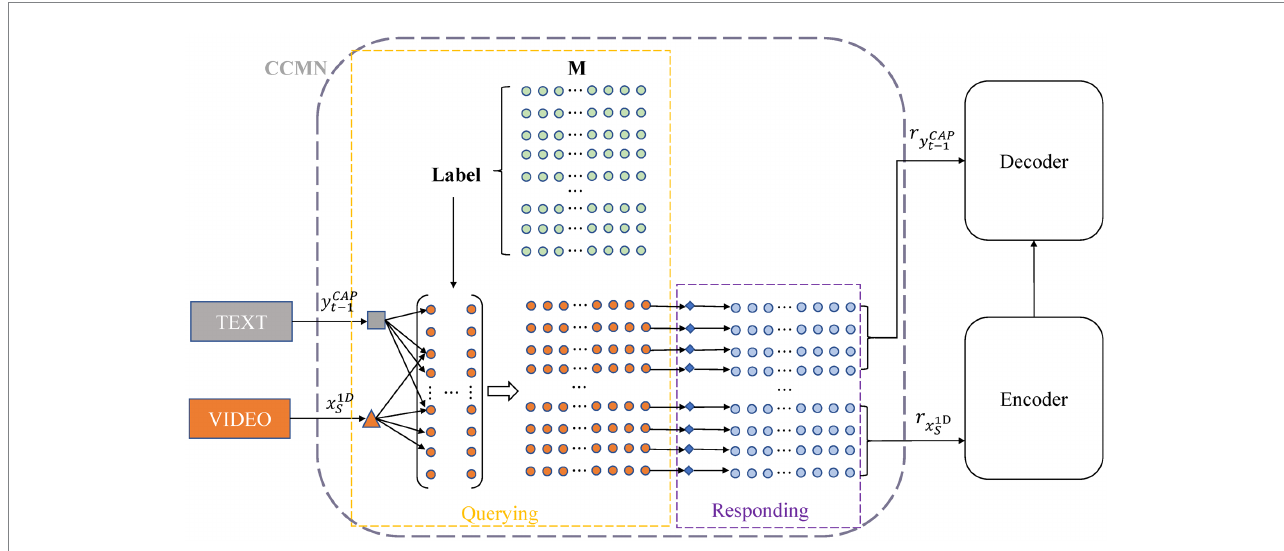
FIGURE 4 Our cross-modal memory network records video features and text features, and the yellow and purple dashed boxes show the process of memory query and response,